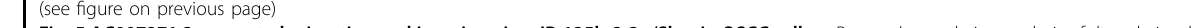
Fig. 5 AC007271.3 promoted migration and invasion via miR-125b-2-3p/Slug in OSCC cells. a Pearson ’ s correlation analysis of the relationship between AC007271.3 and miR-125b-2-3p ( n = 82). b Western blot analysis was performed to detect the expression of Slug and EMT ‐ related markers after overexpressing (or knocking down) AC007271.3 in SCC9 and SCC15. c MiR-125b-2-3p mimic could reverse the changing expression of Slug and E-cadherin caused by overexpressed AC007271.3. d – e Effects of pcDNA3.1( + )-AC007271.3, miR-125b-2-3p mimic, si-Slug on the migration d and invasion e in SCC9 and